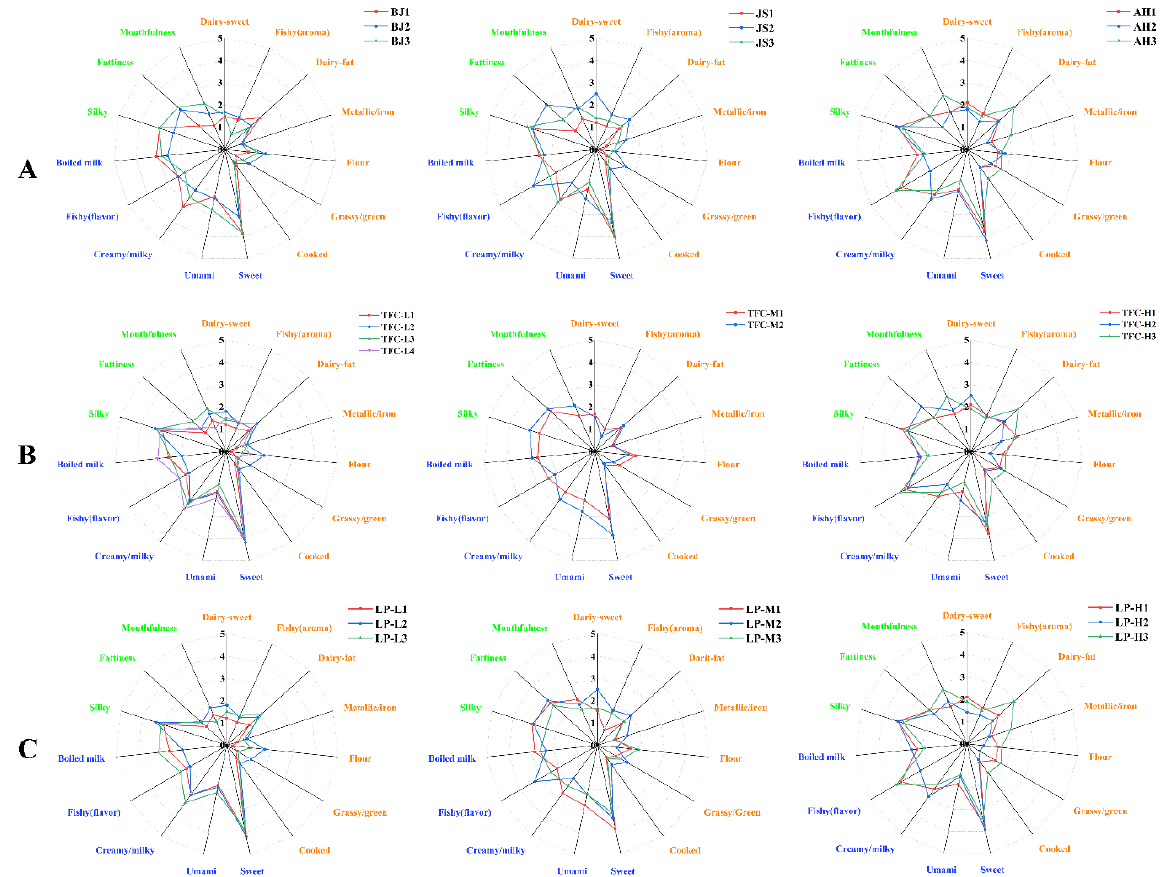
Figure 4. The sensory profile spider-web diagrams of human milk samples. ( A ) human milk samples from different geographical regions (BJ: Beijing; JS: Jiangsu; AH: Anhui), ( B ) human milk samples with different total fat contents (TFC), ( C ) human milk samples with different lactation periods (LP). (LP-H: high lactation period; LP-M: medium lactation period; LP-L: low lactation period; TFC-H: high total fat content, TFC-M: medium total fat content; TFC-L: low total fat content; BJ: Beijing; JS: Jiangsu; AH: Anhui). The sensory intensity of human milk was quantitatively scored on a scale of 0 to 5 with 0.5 increments, where “0” means that the flavor was not felted, and “5” means that the flavor was strong.)